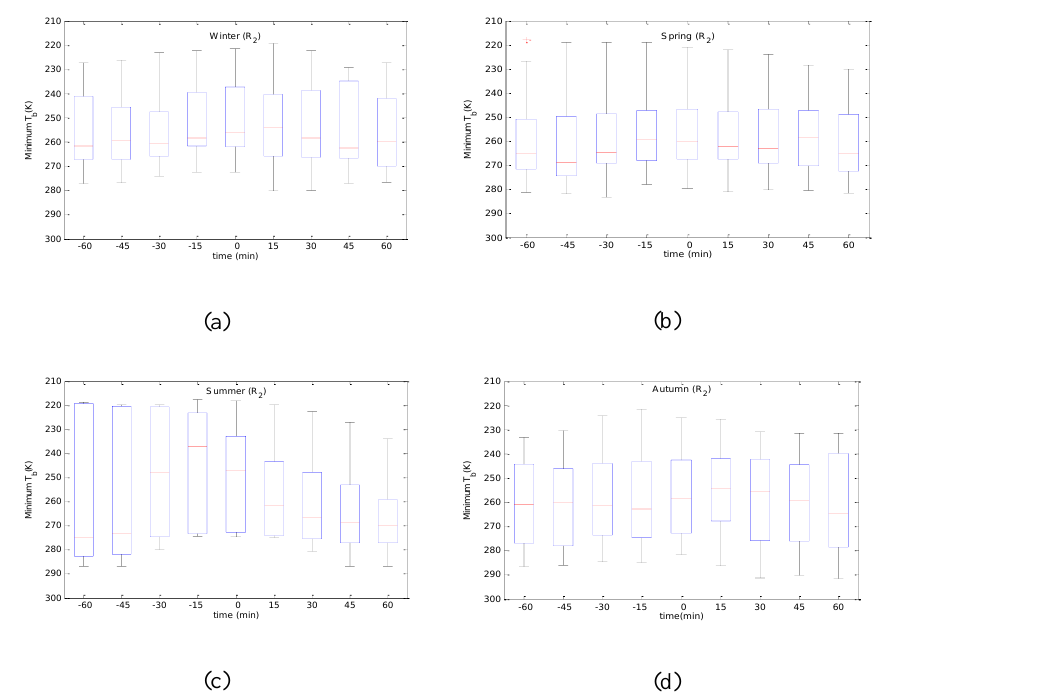
Figure 3. Box and whisker plots of minimum brightness temperature (BT) distribution (in K) at 60min prior to and 60min after waterspout formation, for R 2 search radius, during spring (a) , summer (b) , autumn (c) , and spring (d) waterspout days over the northern Ionian Sea (2007–2013). On each plot, boxes show the upper (75th) and lower (25th) percentiles, the median (horizontal red line), while the whiskers extended to the most extreme data points, and outliers are plotted individually (red